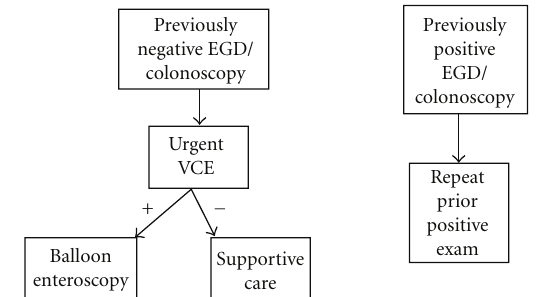
Figure 2: Decision algorithm for the evaluation of VAD patients with recurrent obscure-overt gastrointestinal